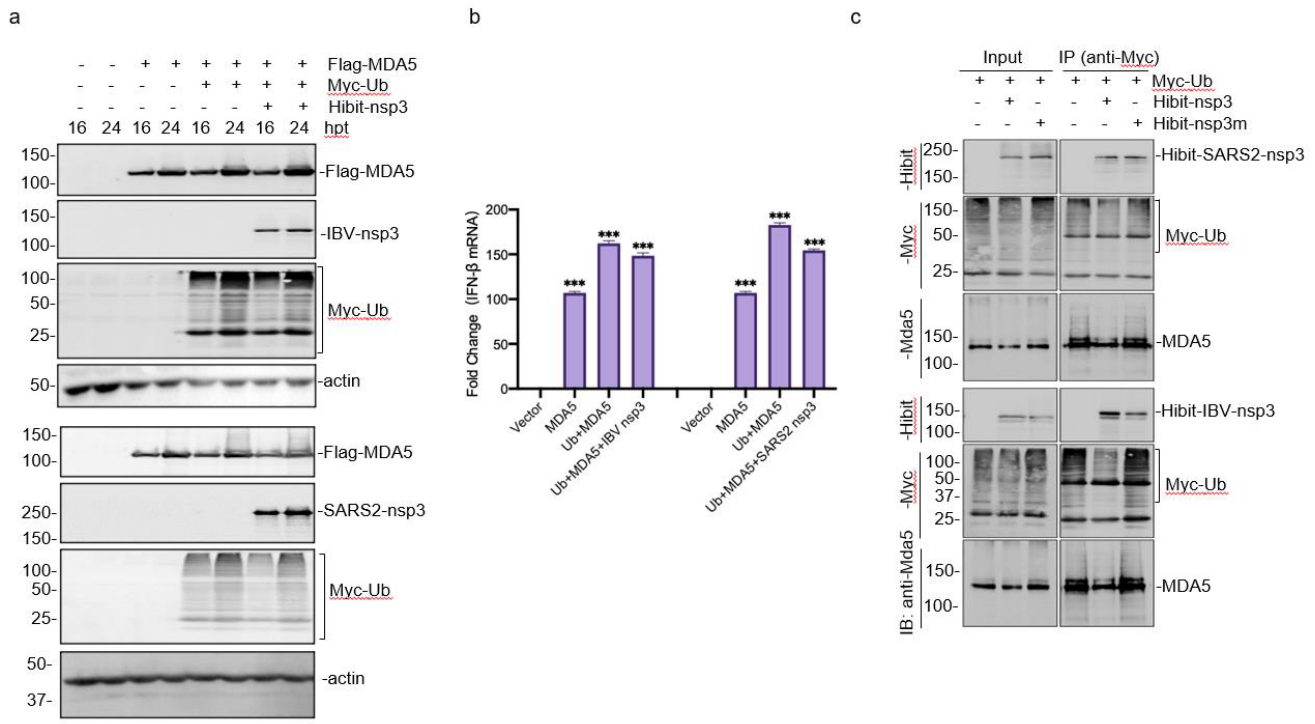
Figure 6. Enhancement of the MDA5-mediated IFN- β induction by ubiquitylation. ( a ) Western blot analysis of the expression of Flag-MDA5 co-transfected with Myc-Ub and Hibit-tagged SARS-CoV-2 or IBV nsp3. HEK293T cells were transfected either with Flag-MDA5 alone or together with Myc-Ub, and Hibit-tagged SARS-CoV-2 or IBV nsp3. Cells were harvested at 16 and 24 h post-transfection (hpt), respectively, and subjected to Western blot analysis with anti-FLAG and anti-Hibit antibodies, respectively. Beta-actin was included as the loading control. Sizes of protein ladders in kDa are indicated on the left. ( b ) Effects of co-expression of MDA5 with Ub and SARS-CoV-2 or IBV nsp3 on the MDA5-mediated IFN- β induction. Total RNA was extracted from cells harvested in ( a ), and IFN- β levels were determined by RT-qPCR after normalization with the GAPDH mRNA extracted from cells transfected with the empty vector. Significance levels were presented by the p -value (ns, non-significance, *, p < 0.05;**, p < 0.01; ***, p < 0.001). ( c ) Co-immunoprecipitation of Ub with MDA5 and wild-type and mutant SARS-CoV-2 or IBV nsp3. HEK293T cells were transfected with Myc-Ub alone or together with Hibit-tagged wild-type and mutant SARS-CoV-2 or IBV nsp3, harvested at 24 h post-infection, total cell lysates prepared, and subjected to immunoprecipitation with anti-Myc beads. Total cell lysates and precipitates were analyzed by Western blot with anti-Myc, anti-MDA5, and anti-Hibit antibodies, respectively. Numbers on the left indicate protein sizes in kilodalton.